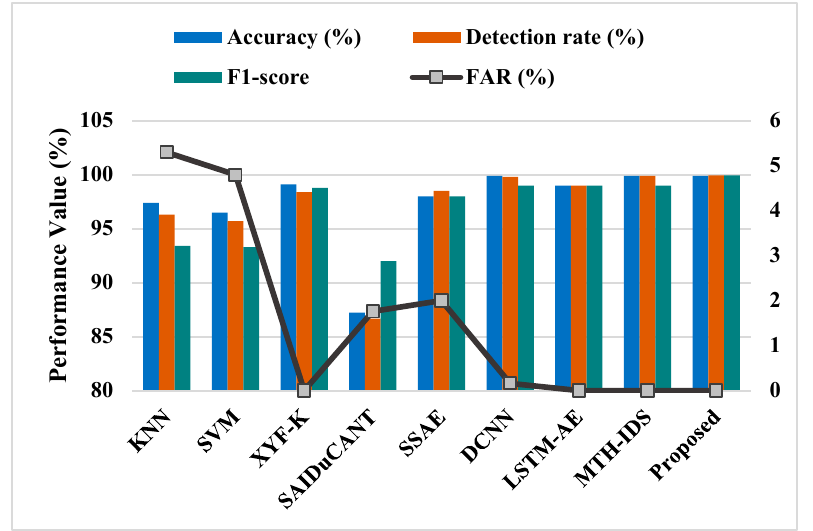
Figure 20. Overall performance analysis using dataset 2.